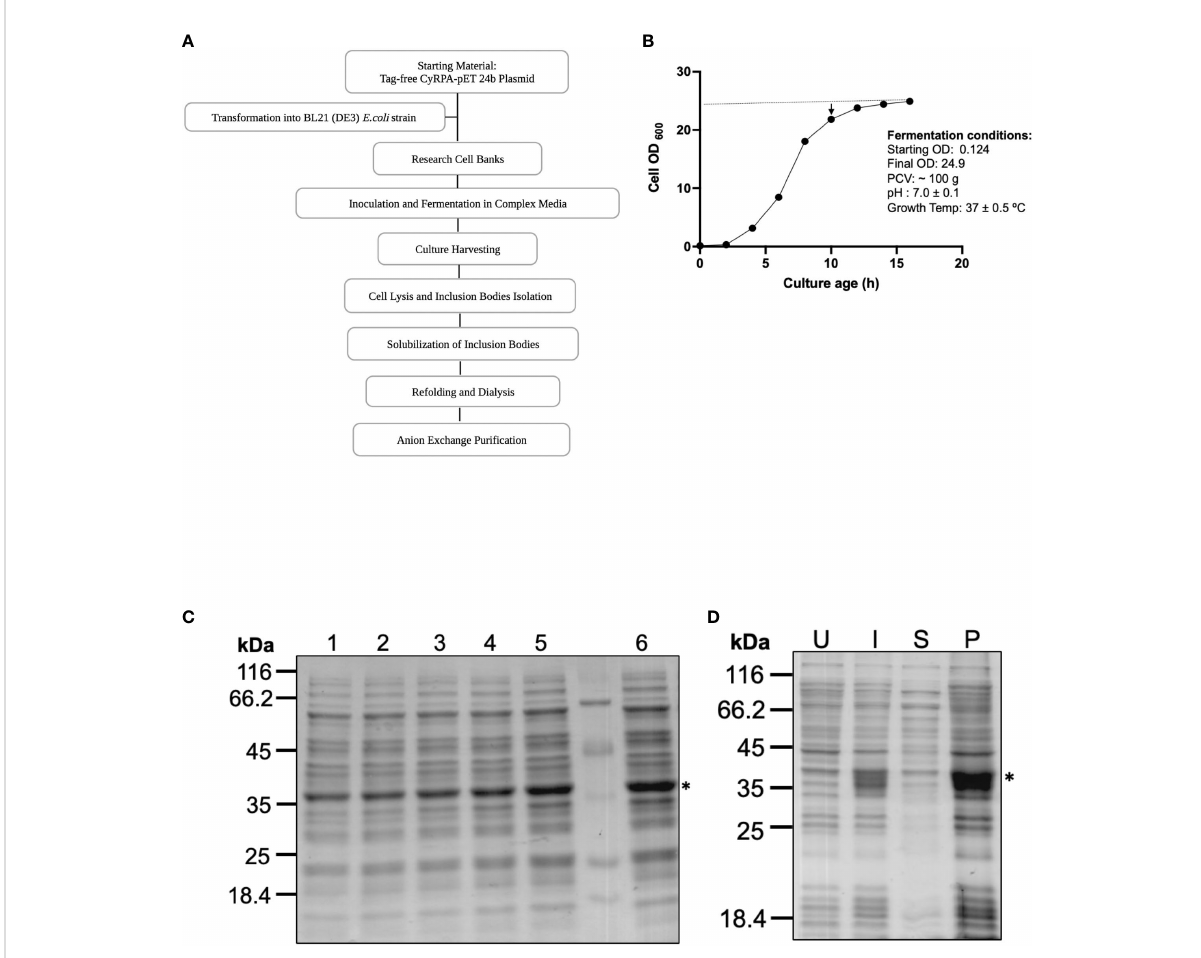
FIGURE 2 Process Development for Large Scale Production of Tag-free CyRPA. (A) Flow chart depicting the steps involved in the process development of tag-free CyRPA. (B) Time-point graph showing the entire 16 hours long fermentation run for CyRPA expressing BL21 (DE3) cells biomass production. Arrowhead indicates induction time point after 10 hours of culture growth. At this point, culture has started to enter the stationary phase. Dotted line shows that a constant pH was maintained throughout fermentation process. (C) CyRPA expression was monitored each hour by SDS-PAGE, which con fi rmed protein expression at different time points (1,2,3,4,5 and 6 hours) after induction. (D) Post fermentation, the expression of CyRPA was checked by reducing SDS-PAGE in uninduced, induced, supernatant and pellet fractions after cell lysis. Consistent with small scale results, expression can be found in pellet fraction or inclusion bodies. * indicating the position of CyRPA. UI, Uninduced; I, Induced; S, Supernatant; P,